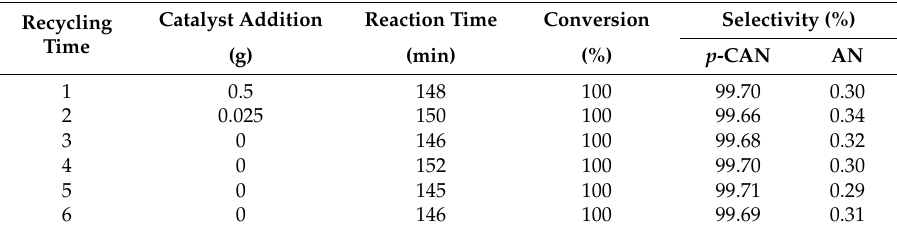
Table 3. Recycling of Pd-P(32)/C(400) catalyst for selective hydrogenation of p -CNB under solvent-free